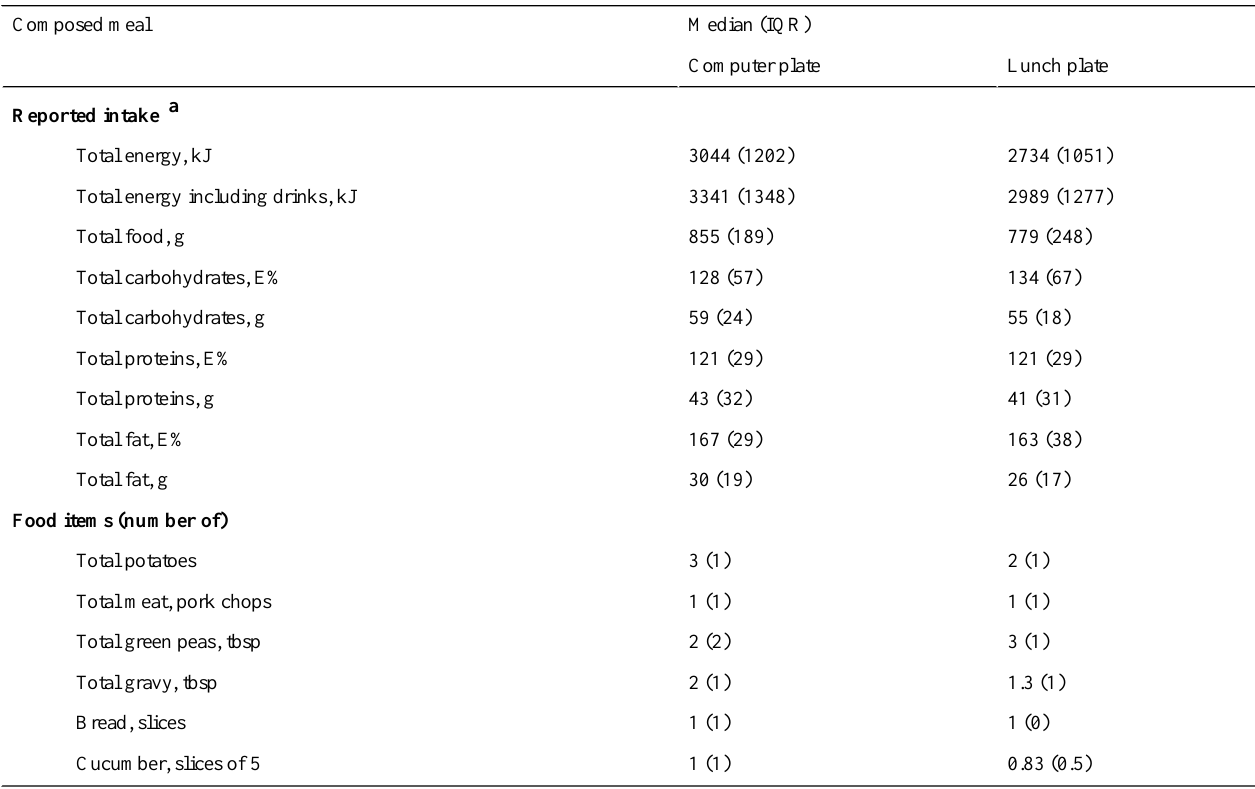
Table 2. Study participants’composed meals using the two meal instruments (N=51).